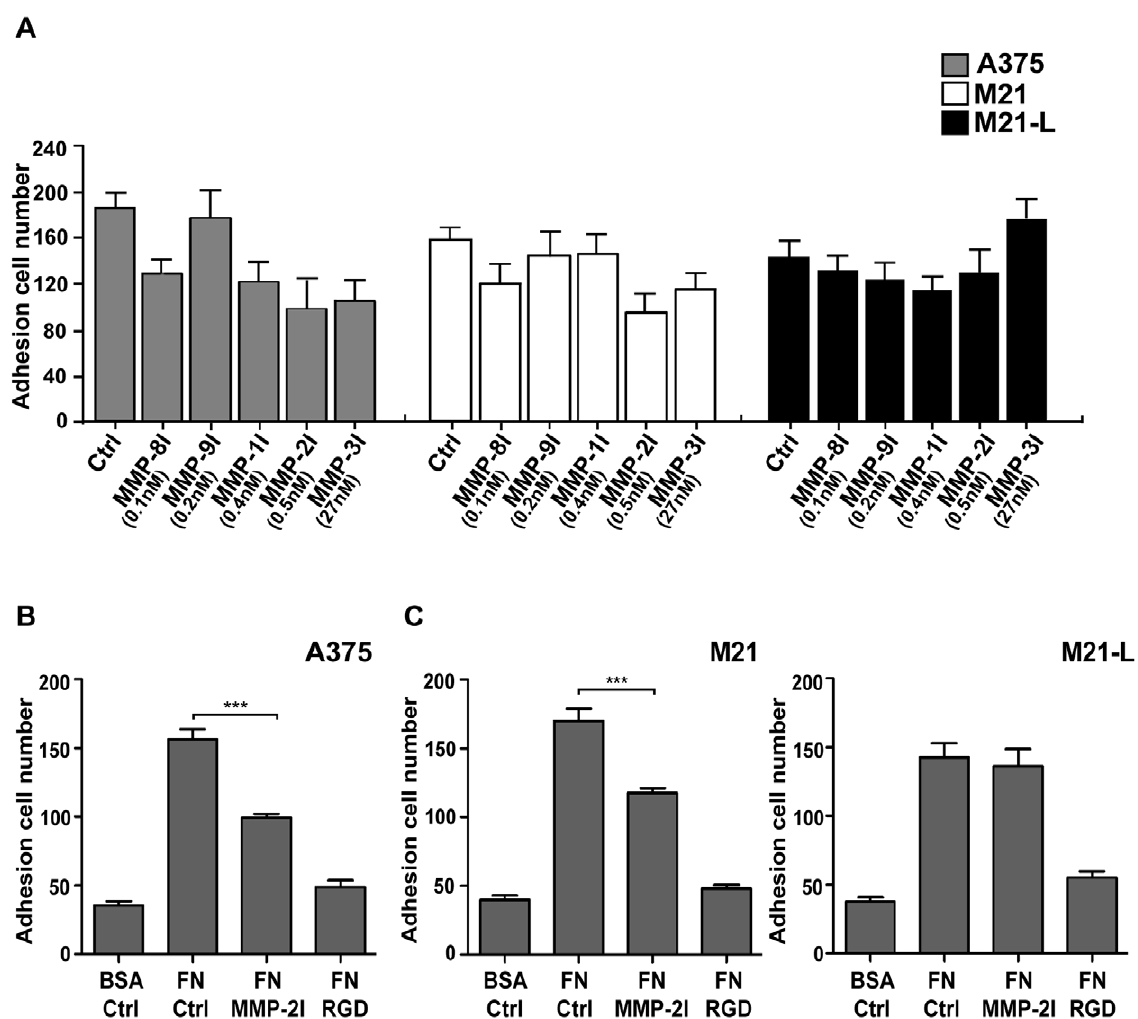
Figure 3. The effect of GM6001 on the adhesion of human melanoma cells. (A) Human melanoma cells, A375, M21 and M21-L, were treated with different concentrations of GM6001, then fluorescently stained and seeded on 48-well plates coated with 10 m g/ml human fibronectin (FN). GM6001 (a broad spectrum hydroxamate MMPs inhibitor) was applied at different concentrations in order to address the role of MMP individuals on the tumor cell adhesion as described in MATERIALS AND METHODS. (B) A375 cells were seeded on human fibronectin (FN) or 0.5% bovine serum albumin (BSA)-coated 48-well plates for 30 min. The cells were treated with or without RGD peptides or 0.5 nM GM6001; (C) M21 and M21-L cells were seeded on human fibronectin (FN) or 0.5% BSA-coated 48-well plates for 30 min. The cells were treated with or without RGD peptides or 0.5 nM GM6001. The fluorescence intensity was measured using a fluorescence spectrophotometer. Statistical difference were determined by comparing the treated group with the normal control by t-test (***, P ,